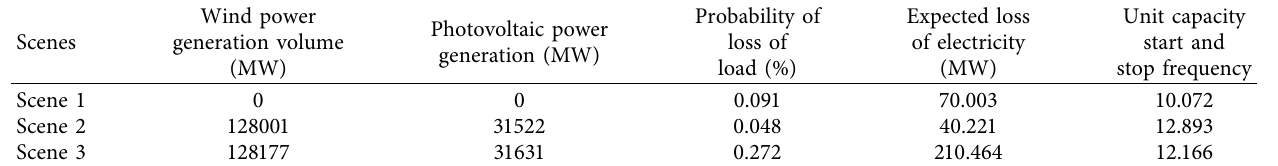
Table 2: Simulation results for each